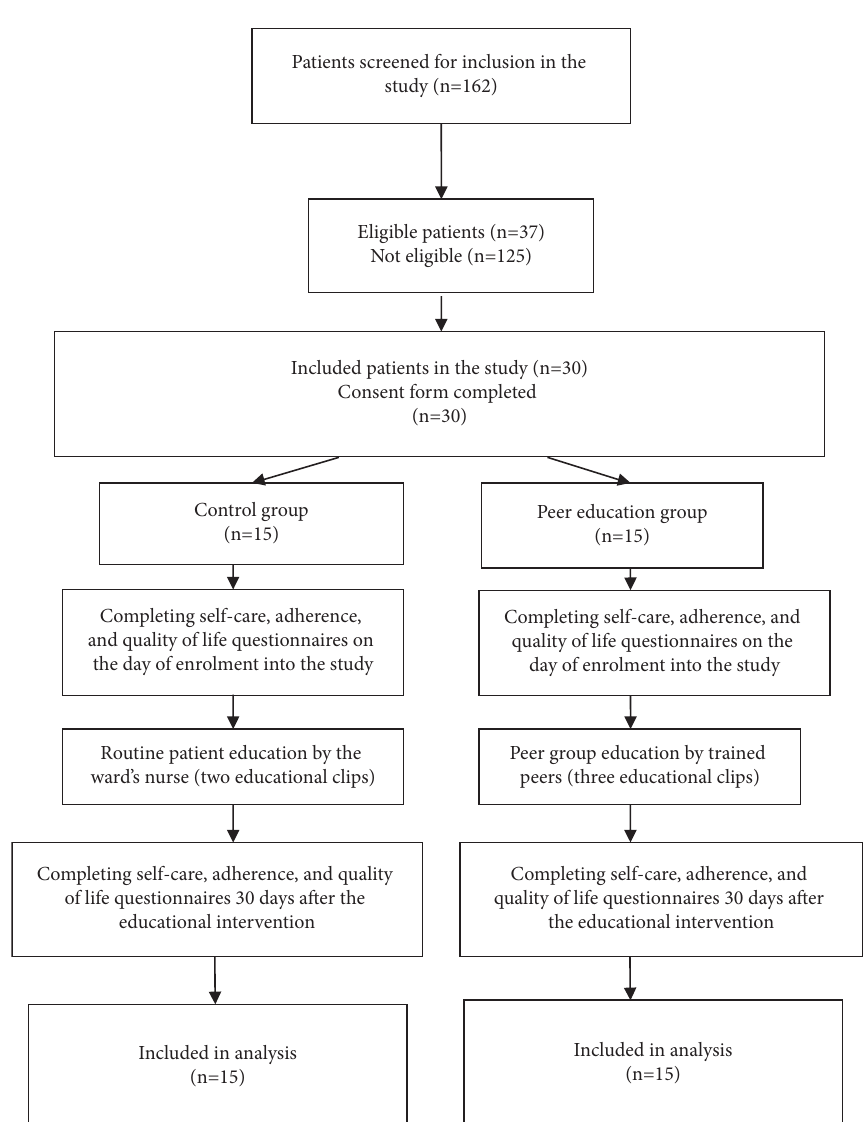
Figure 1: Different steps of the study based on the CONSORT